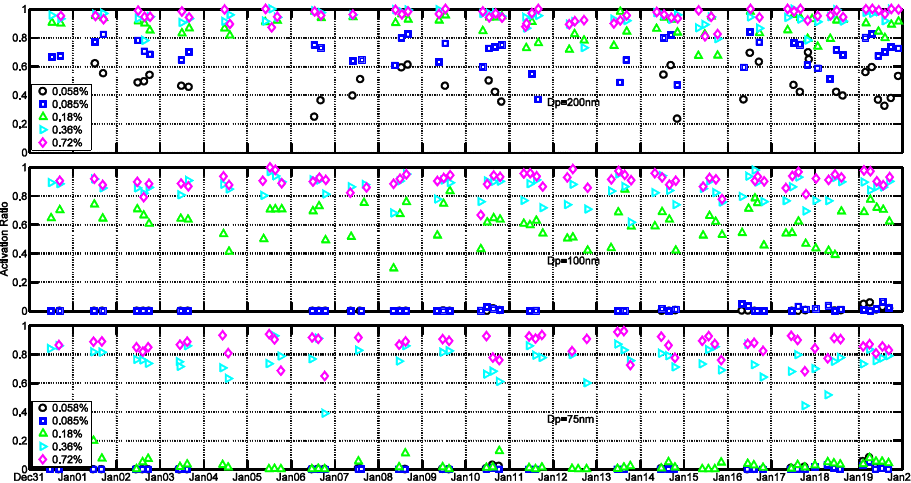
Figure 6 Time Series of the Activation Ratio during January 2010 2 3 Fig. 6. Time series of the activation ratio during January 2010.